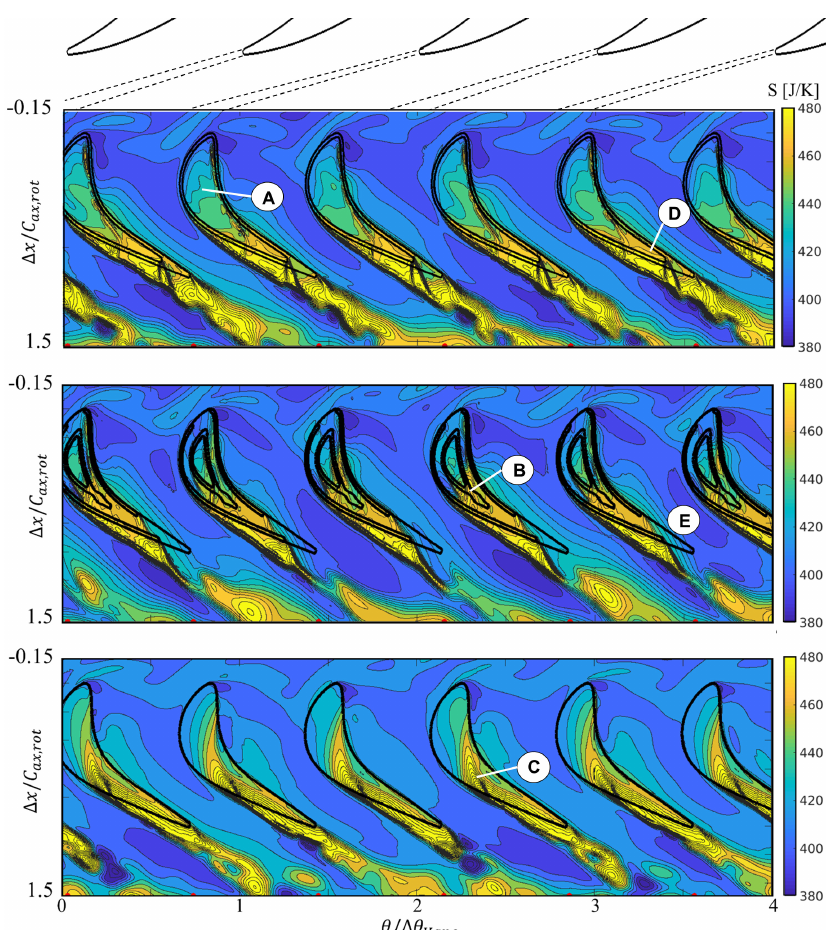
Figure 5. Contours of time resolved mid-gap entropy in the vane frame for (top to bottom): IN01D, AC06D, and